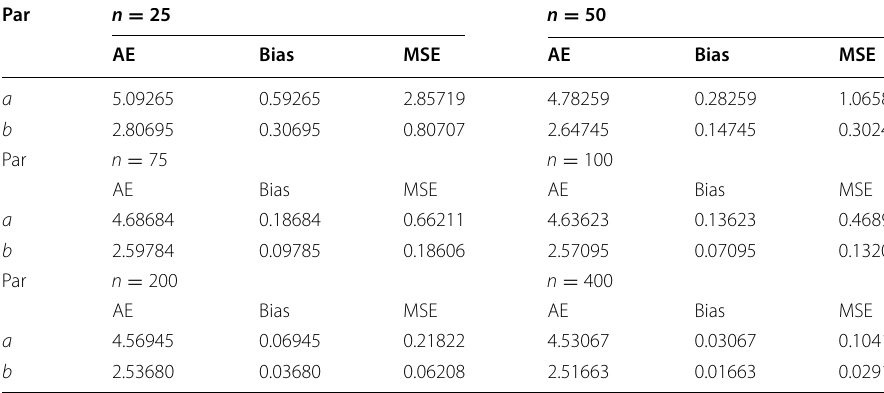
Table 2 Monte Carlo simulation results for scenario 2